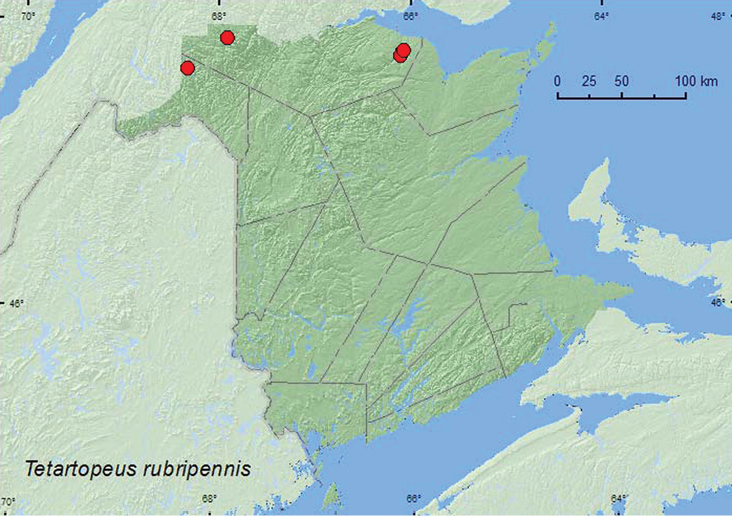
Collection localities in New Brunswick, Canada of Tetartopeus rubripennis.